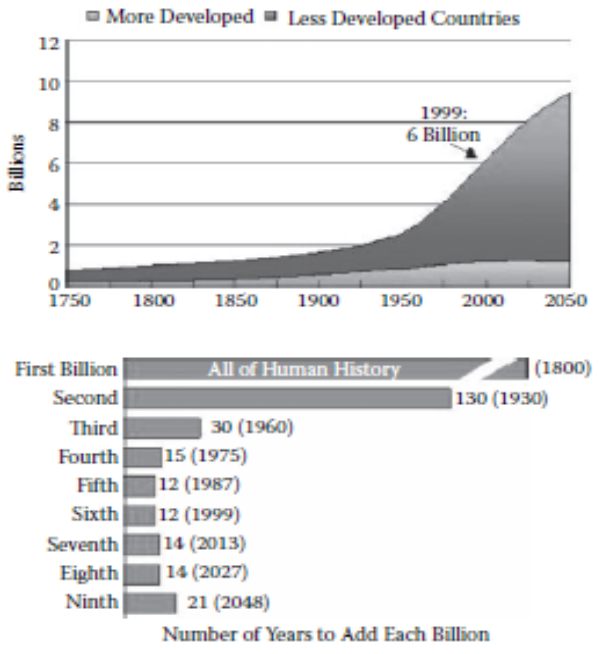
Figure 1. Population trend from 1750 to 2050 [3]